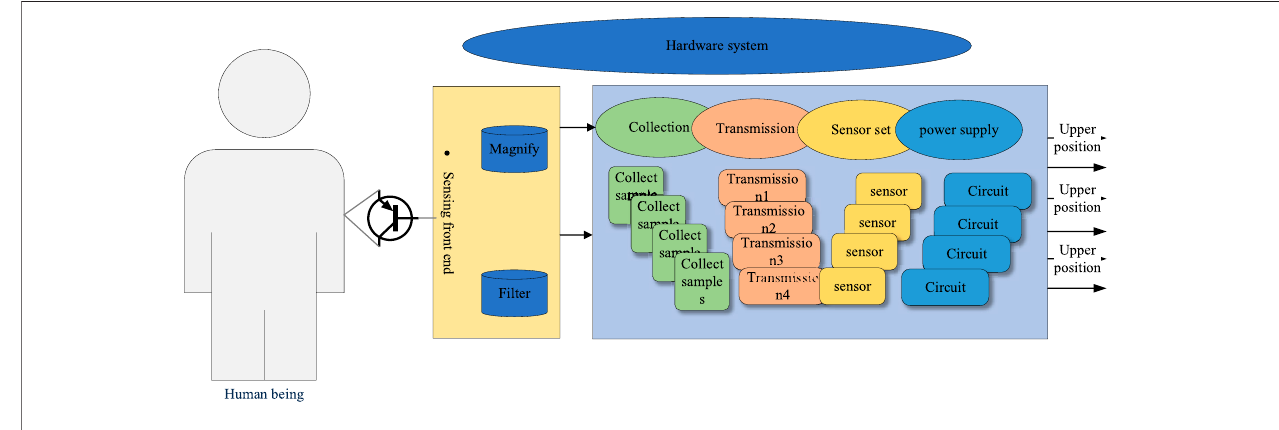
FIGURE 1 | Hardware composition of the acquisition